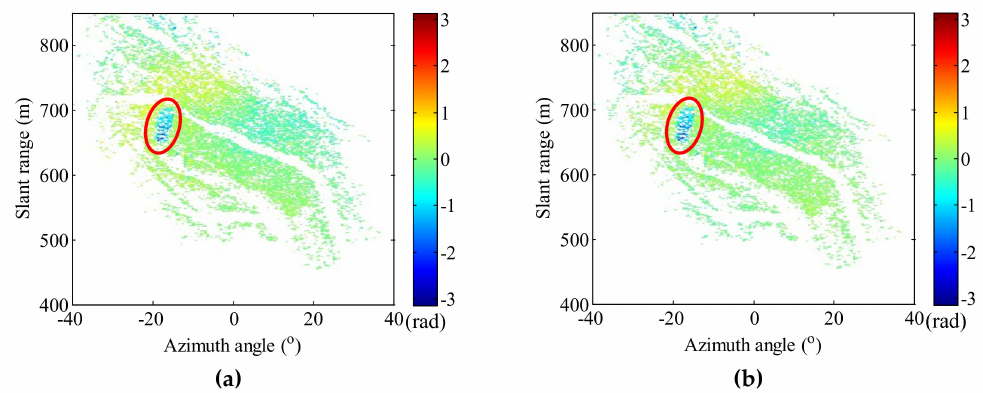
( 30 ) with ( a ) a second order model of range and B